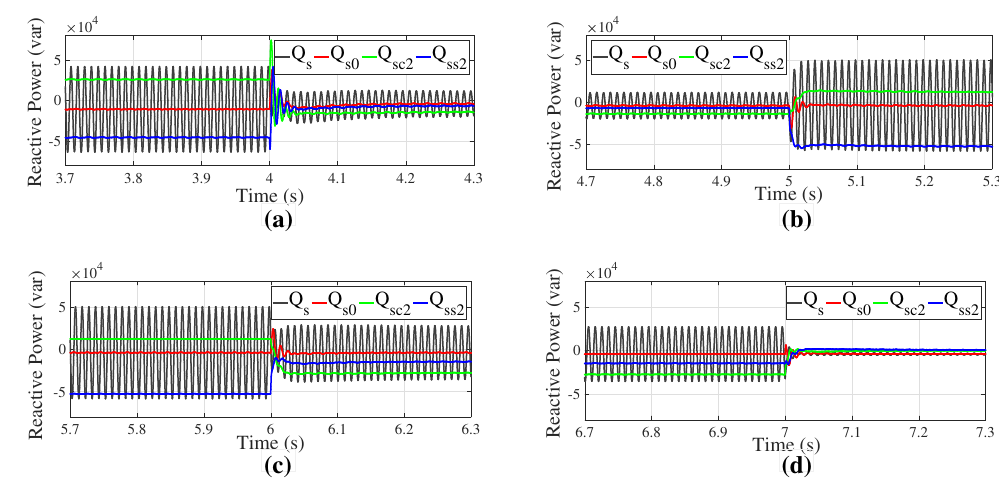
Figure 7. Evolution of the reactive power (var) when changing from: ( a ) regular control strategy (no compensation to address the voltage imbalance) to Objective I; ( b ) Objective I to Objective II; ( c ) Objective II to Objective III; and ( d ) Objective III to Objective